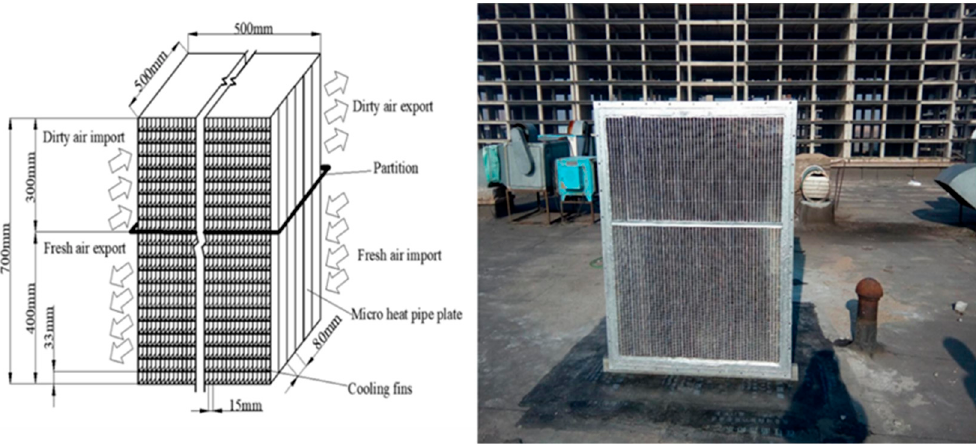
Figure 2. Structural representation of the micro heat pipe low-temperature flue gas heat exchanger